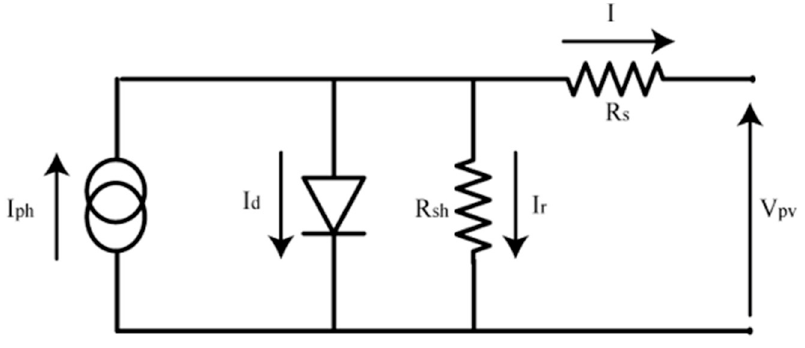
Figure 5. Wind turbine system.